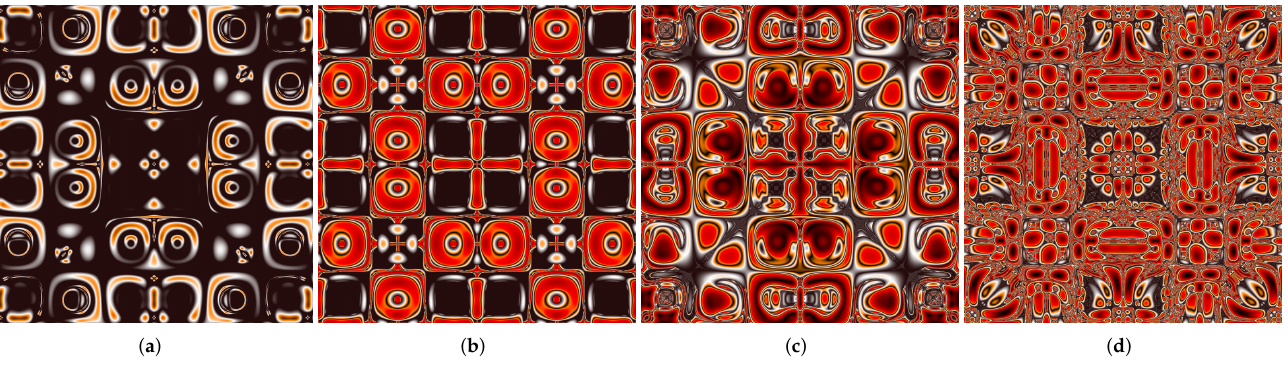
Figure 8. Patterns generated with function f with p4m symmetry, orbit traps from Figure 3b, and S-iteration with varying scalar α and β parameters. ( a ) α = [ 1.1,0 ] T , β = [ 1.1,0 ] T ; ( b ) α = [ 1.5,0 ] T , β = [ 1,0 ] T ; ( c ) α = [ − 1.5,0 ] T , β = [ 1.3,0 ] T ; and ( d ) α = [ 2,0 ] T , β = [ − 1.1,0 ] T